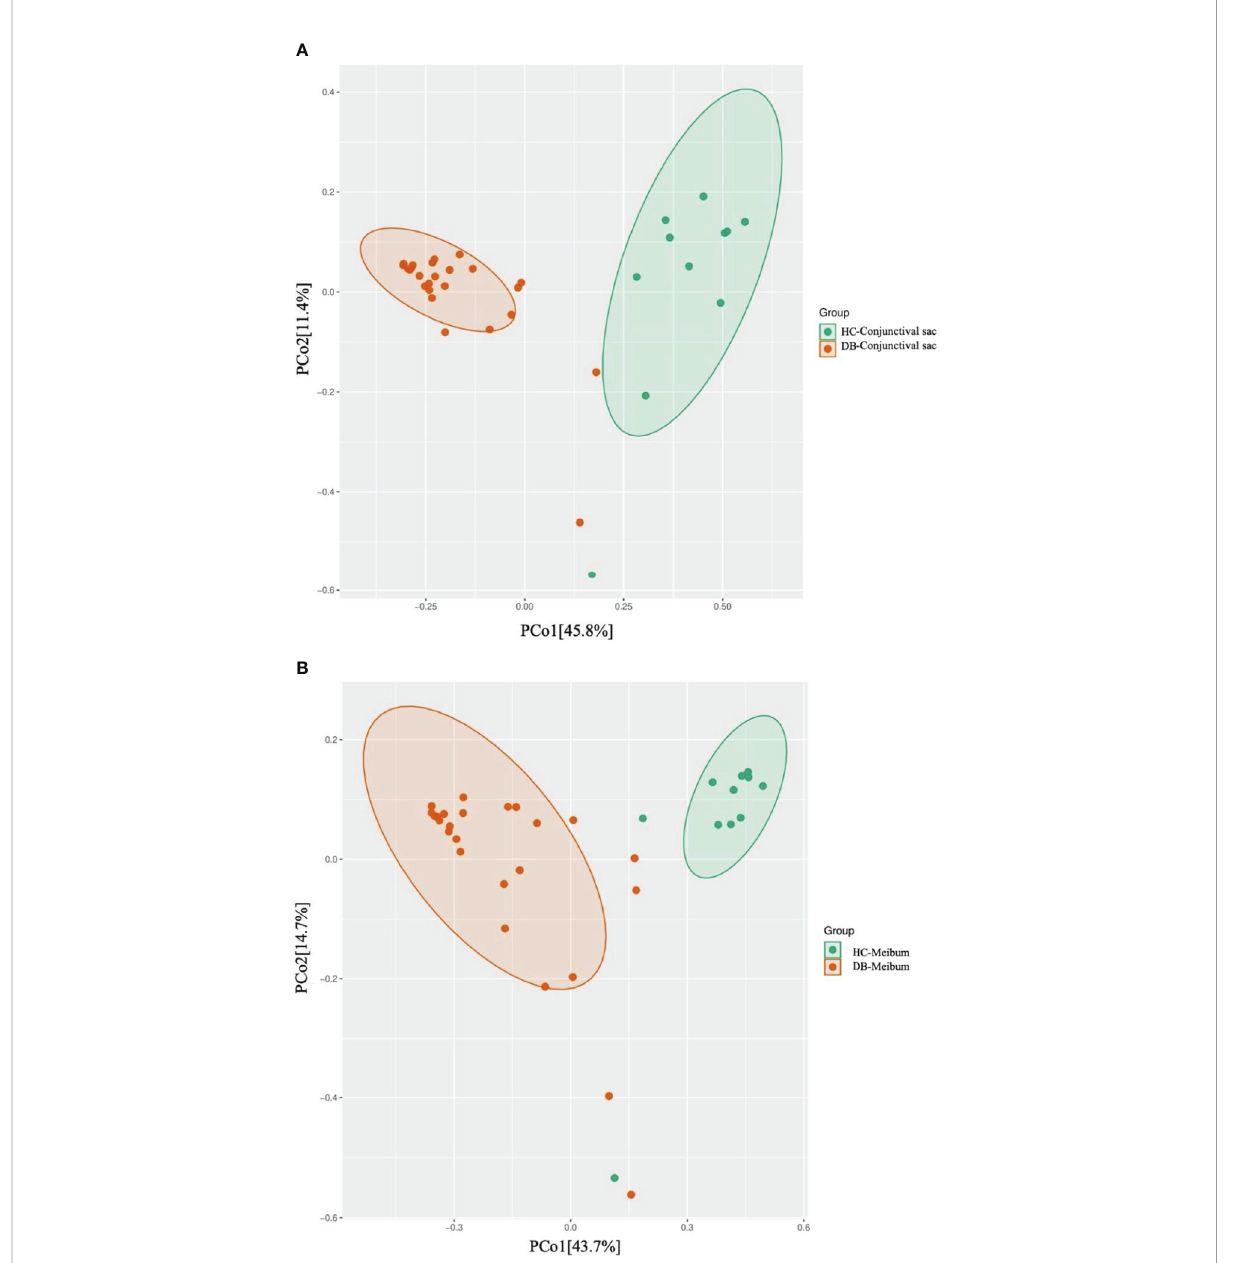
FIGURE 5 Principal coordinate analysis of two groups of conjunctival sac microbiome (A) and meibum microbiome (B) . HC, Healthy control; DB, Demodex